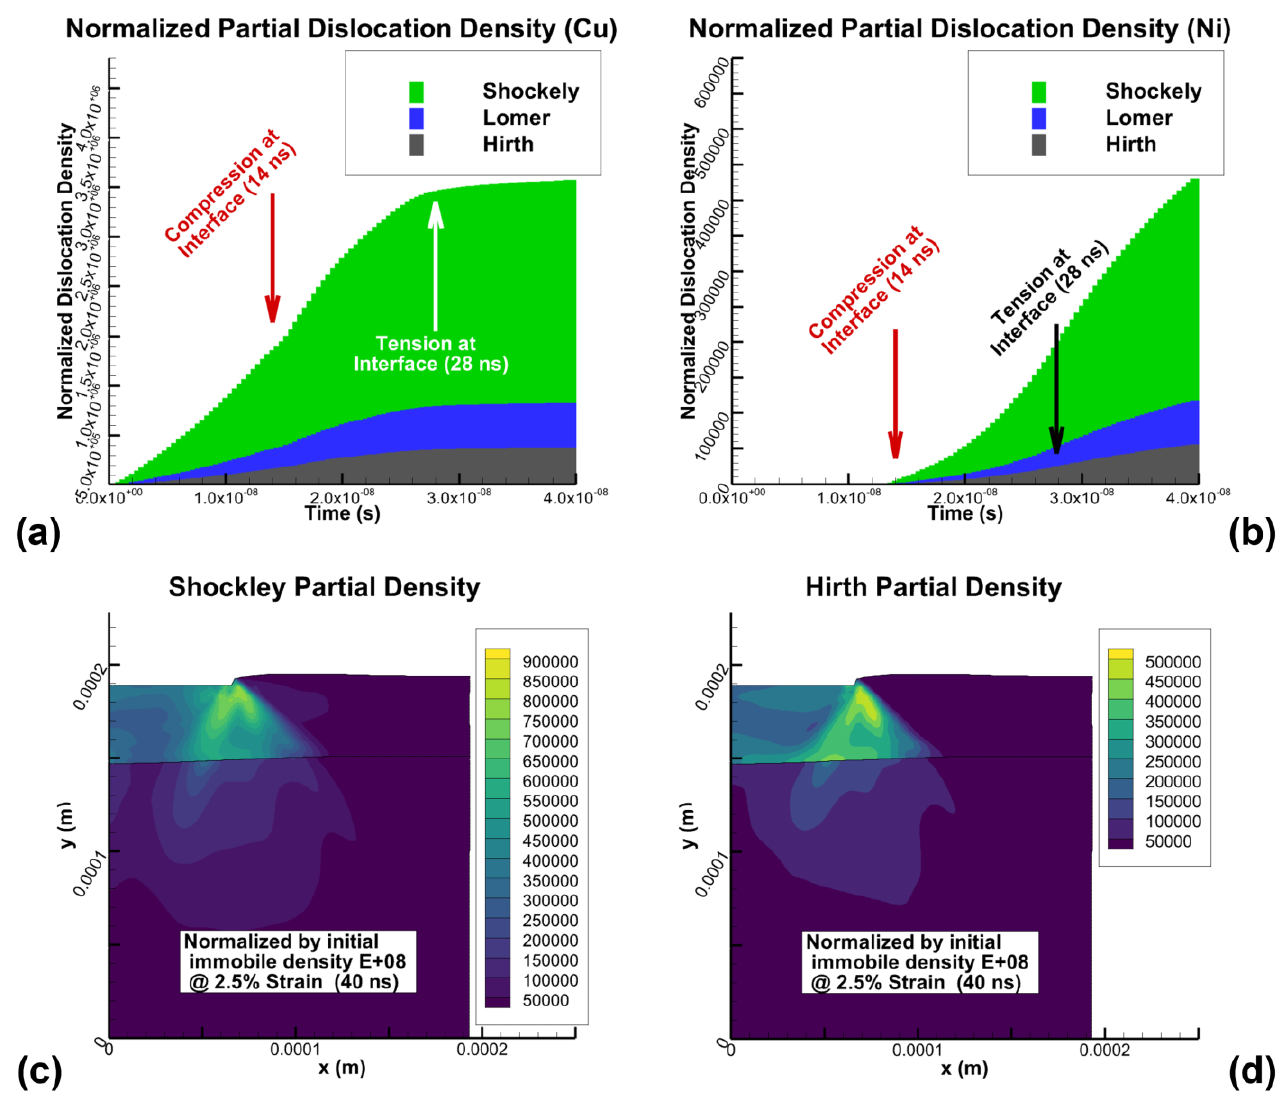
Figure 8. ( a ) Stacking bar charts of normalized partial dislocation densities for the copper layer, and ( b ) for the nickel layer that is activated after the normal stress has reached the interface. ( c ) The density of the dominant Shockley partial dislocation, ⅙[2 ̅ 1 1 ̅ ], and ( d ) the dominant Hirth partial dislocation, ⅓[100] at a nominal strain of 2.5%.